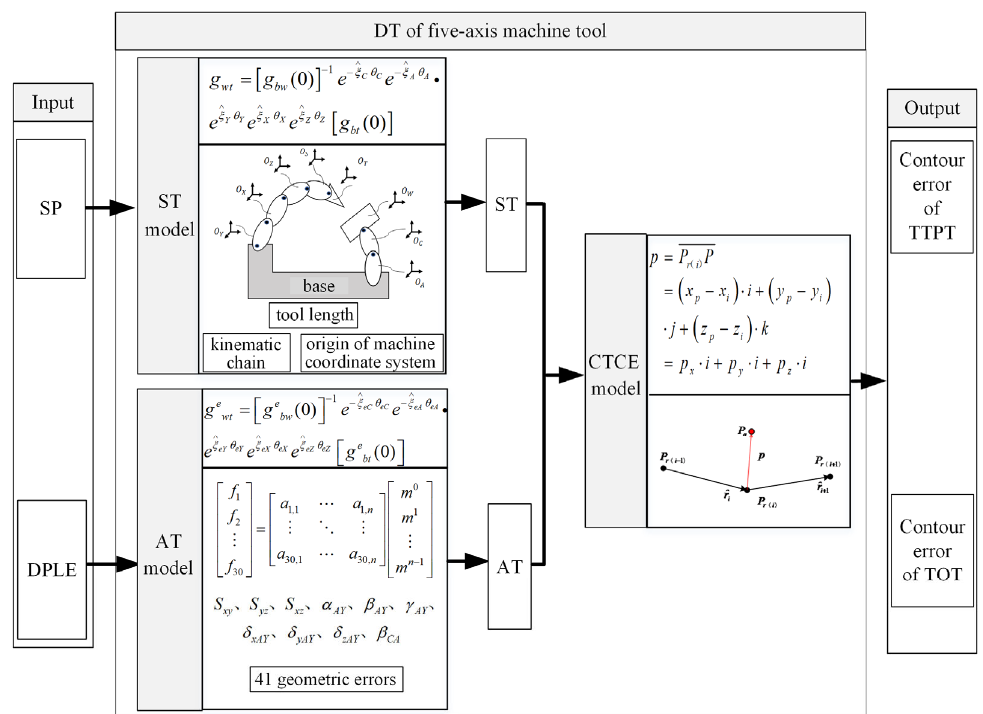
Figure 1. The DT framework of five ‐ axis CNC machine tool.